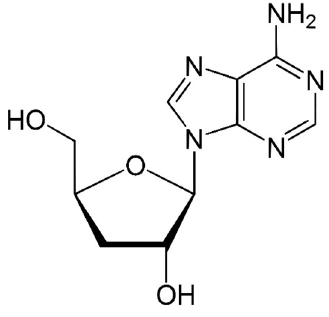
Figure 4. Cordycepin